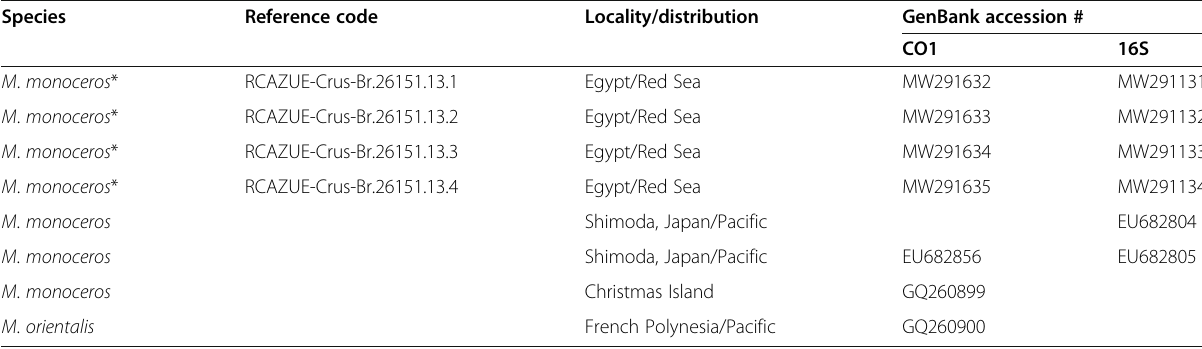
Table 1 GeneBank accession number for the present examined materials of M. monoceros from the Red Sea, Egypt, and other available sequences from (http://www.ncbi.nlm.nih.gov)